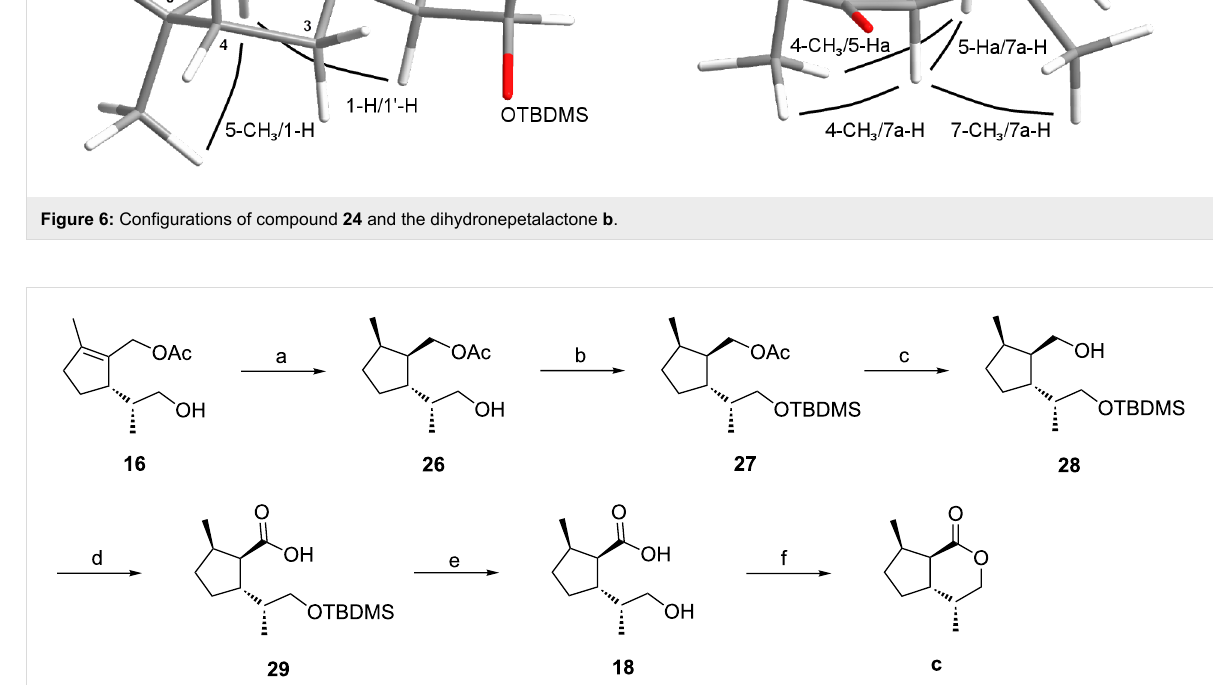
Scheme 4: Synthesis of cis , trans -substituted dihydronepetalactone c . Reaction conditions: a) Crabtree's catalyst [Ir(cod)PCy 3 (py)]PF 6 (11 mol %), 1 bar H 2 , CH 2 Cl 2 , rt (81%); b) TBDMSCl, imidazole, DMF, 0 °C (100%); c) KOH, MeOH, rt (93%); d) RuCl 3 ·3H 2 O (2 mol %), NaIO 4 , CCl 4 , CH 3 CN, phosphate buffer (pH 7), rt (81%); e) HF, CH 3 CN, rt (100%); f) DCC, DMAP, CH 2 Cl 2